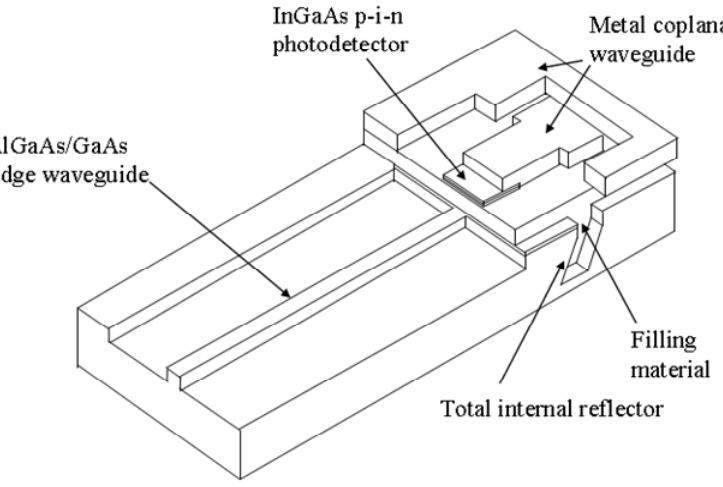
Figure 4. Photodetector monolithically integrated with optical waveguide by the filling material in the TIR